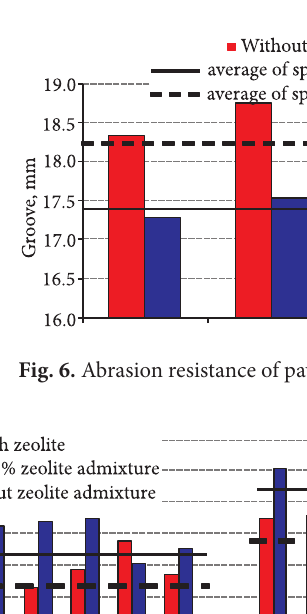
Fig. 5. Abrasion resistance of paving blocks after 7 days